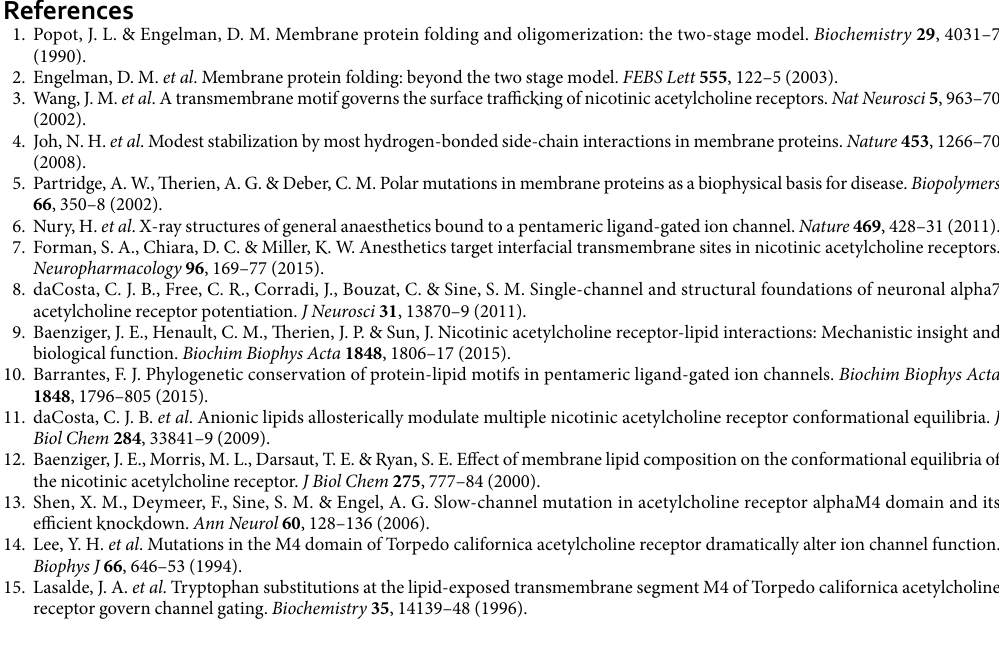
Dose responses for each mutant were acquired from at least two different batches of oocytes. Each individual dose-response experiment was fit with a variable slope sigmoidal dose-response and the individual EC 50 values from each experiment averaged to give the reported EC 50 values ± standard deviation.